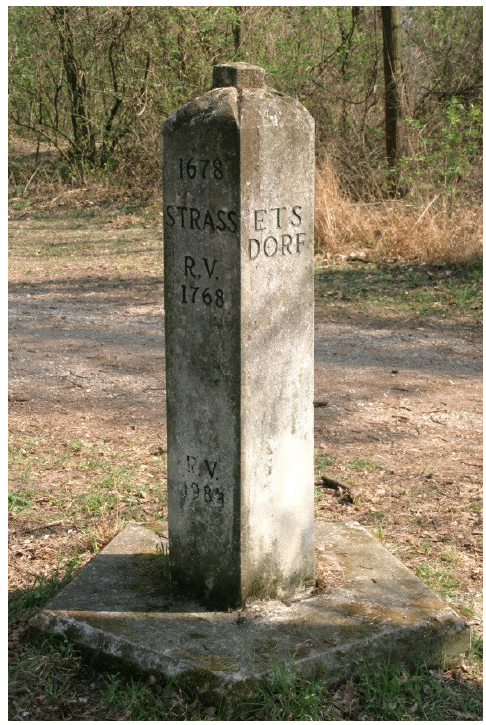
Figure 3. This pentagonal boundary stone from 1678 connects six parcels, five cadastral communities of four political commu- nities in two different districts, a rare situation (Photo H.Koenig)